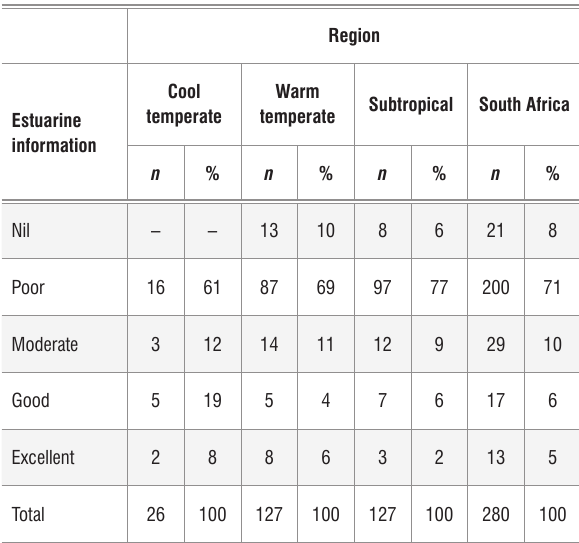
Number and percentage of estuaries in each biogeograph-